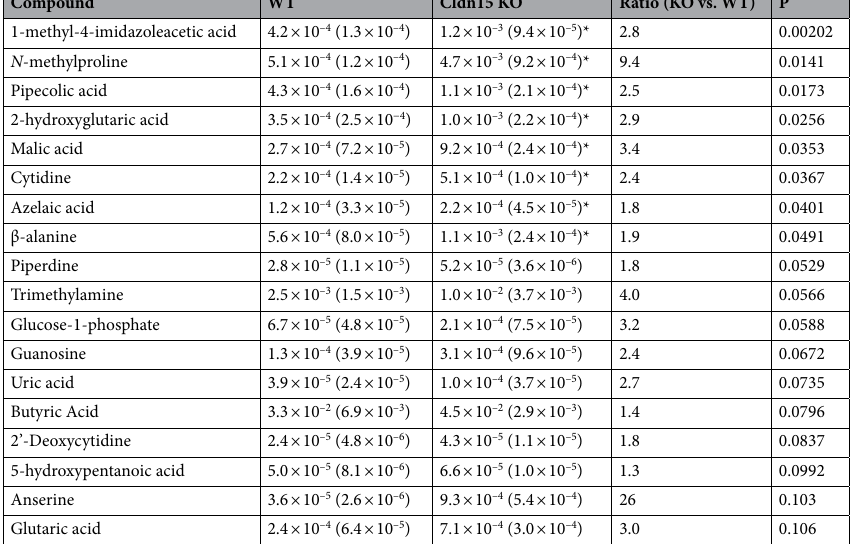
Table 1. Compounds found to be higher in the cecal luminal contents of Cldn15 KO mice. Data are expressed as the mean (SD) relative area of the peak for each metabolite for WT (n = 3) and Cldn15 KO (n = 3). The relative ratio compares the mean KO value vs the mean WT value. Welch’s T -test was used to compare the means, P < 0.05 was considered to be significantly different.